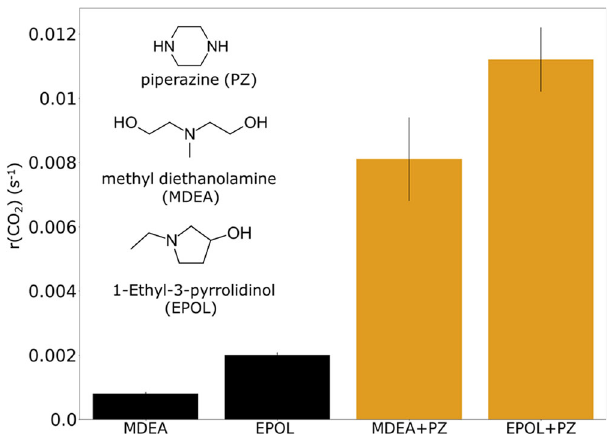
Fig. 4 Experimental kinetic measurements with piperazine.